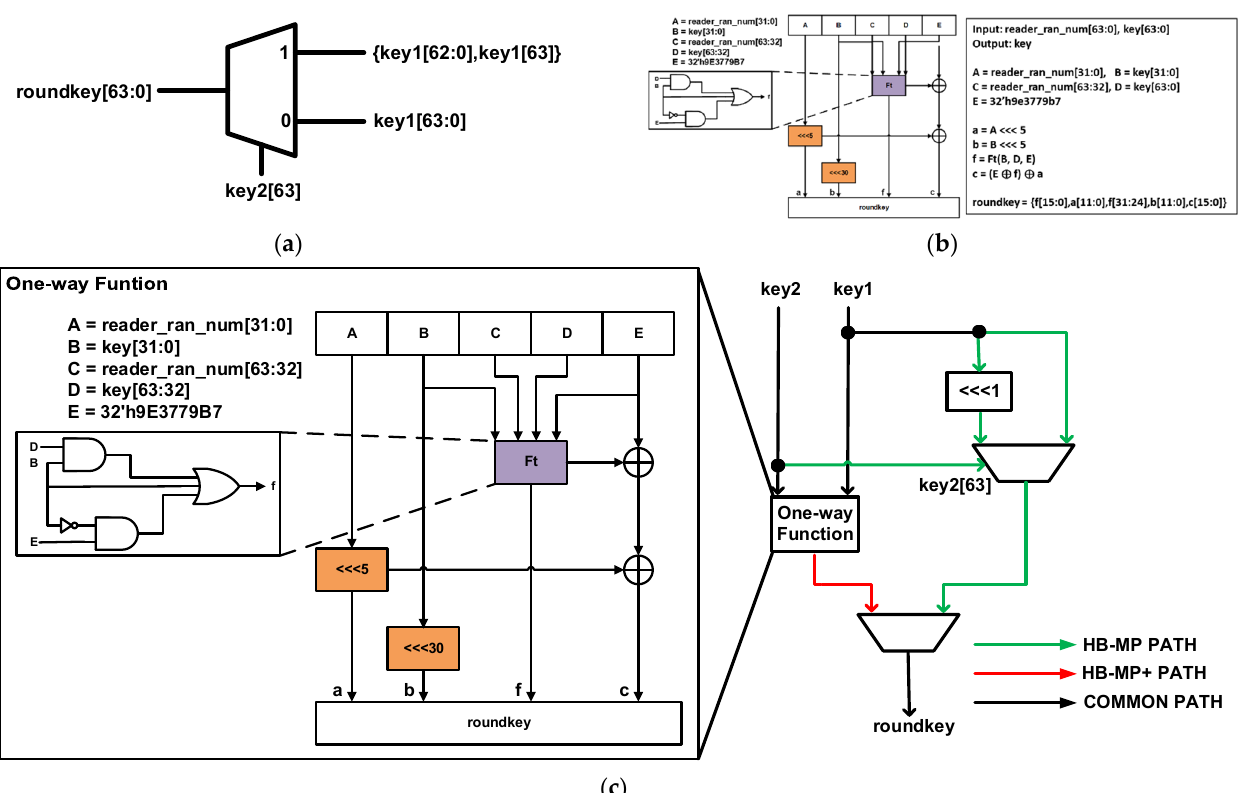
Figure 8. Proposed key generation unit: ( a ) HBMP round key generation; ( b ) HBMP+ round key generation; ( c ) Unified key generation for both HBMP and HBMP+.